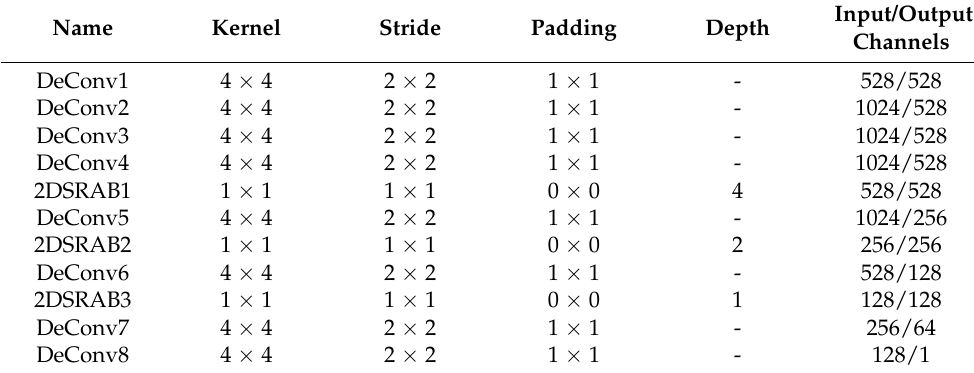
Table 4. Decoder part of the generator used in UA-GAN (Stage